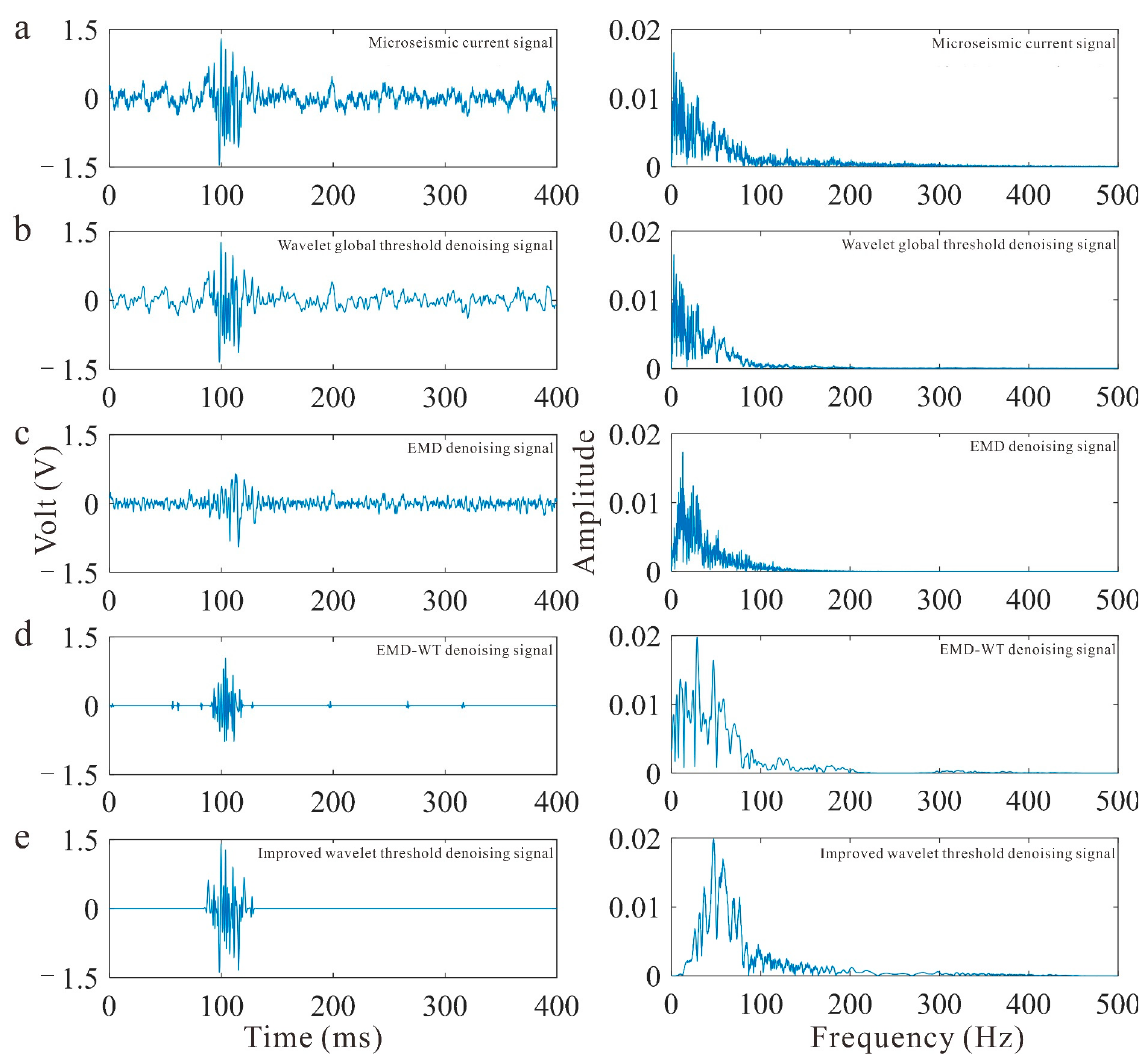
Figure 12. Comparison of denoising effects for an actual microseismic noise signal: ( a ) microseismic noise signal, ( b ) Wavelet global threshold denoising signal, ( c ) EMD denoising signal, ( d ) EMD-WT denoising signal, ( e ) improved wavelet threshold denoising signal.